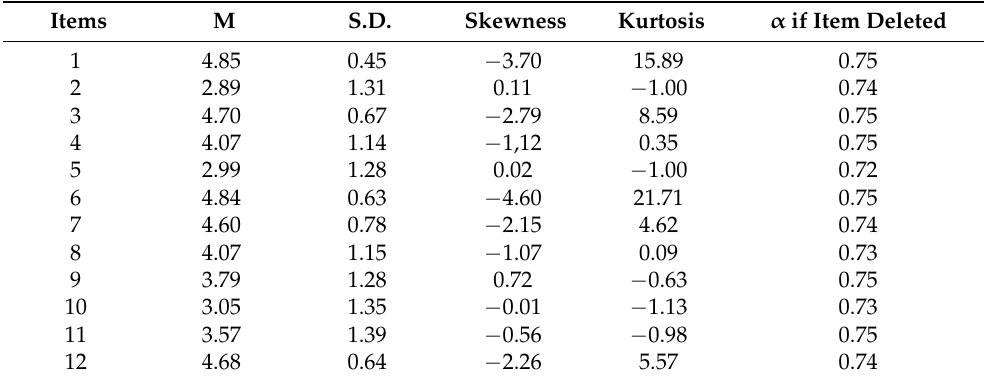
Table 3. The descriptive statistics per